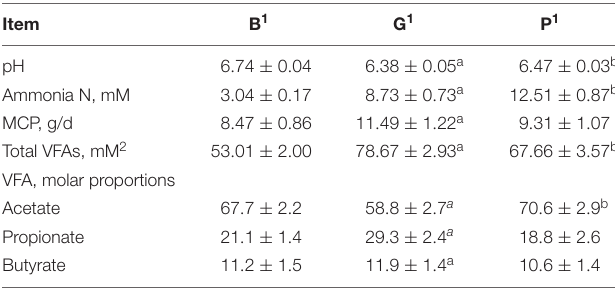
TABLE 3 | Comparisons of rumen pH, ammonia N, MCP, and VFAs concentrations between groups.